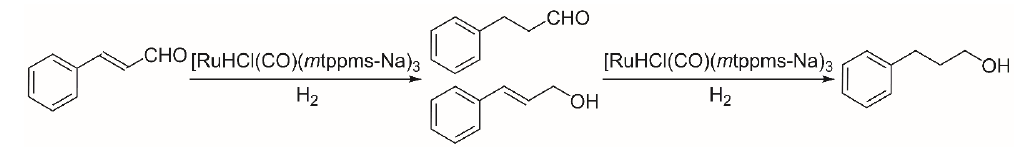
Figure 8. Hydrogenation of cinnamaldehyde.